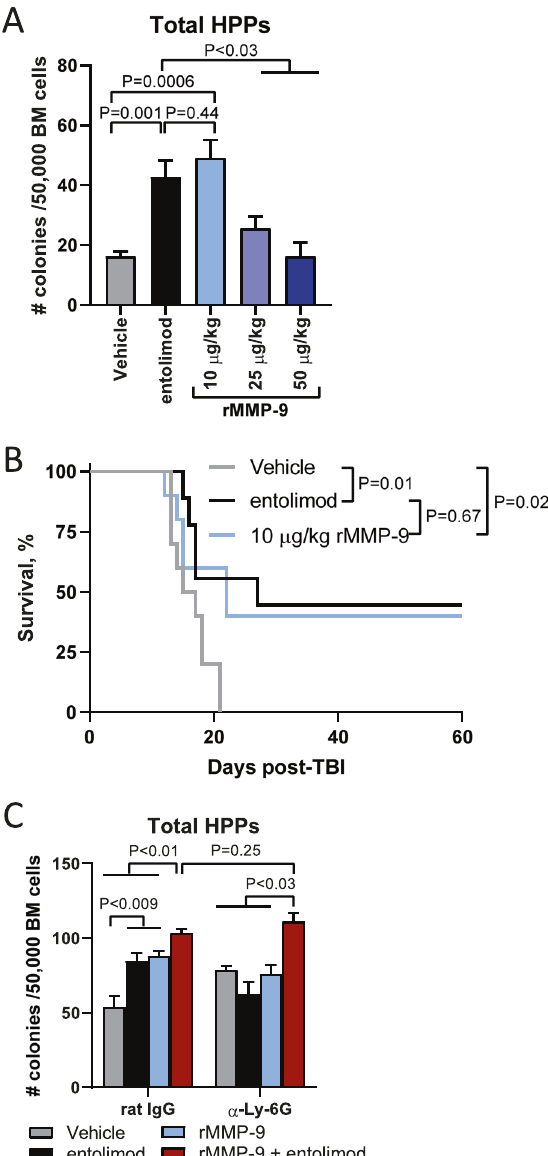
Fig. 5 Release of MMP-9 by N ϕ post-entolimod mitigates lethal radiation damage to hematopoiesis. A BALB/c mice ( n = 5/group) were given 5 Gy TBI followed 24 h later by treatment with vehicle, entolimod, or the indicated doses of recombinant pro-MMP-9 (rMMP-9). Measurement of total HPPs in BM by MethoCult was done on day 3 post-treatment. B Survival by Kaplan – Meier curve in BALB/ c mice treated with vehicle, entolimod, or 10 μ g/kg rMMP-9 24 h post 7.5 Gy TBI ( n = 9 – 10 mice /group). P -values were determined by the Log-rank test. C BALB/c mice ( n = 5/group) were given 5 Gy TBI followed 6 h later by rat IgG or α -Ly-6G. Twenty-four hours later mice were treated with vehicle, entolimod, rMMP-9 (10 μ g/kg), or rMMP-9 plus entolimod. Measurement of total HPPs in BM by MethoCult